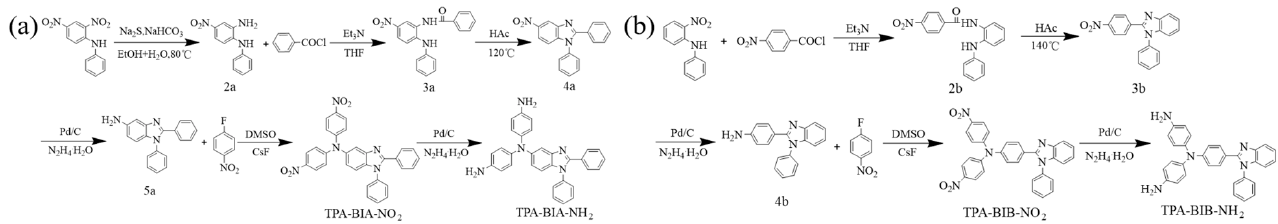
Scheme 1. Synthetic route of TPA-BIA-NH 2 ( a ) and TPA-BIB-NH 2 ( b